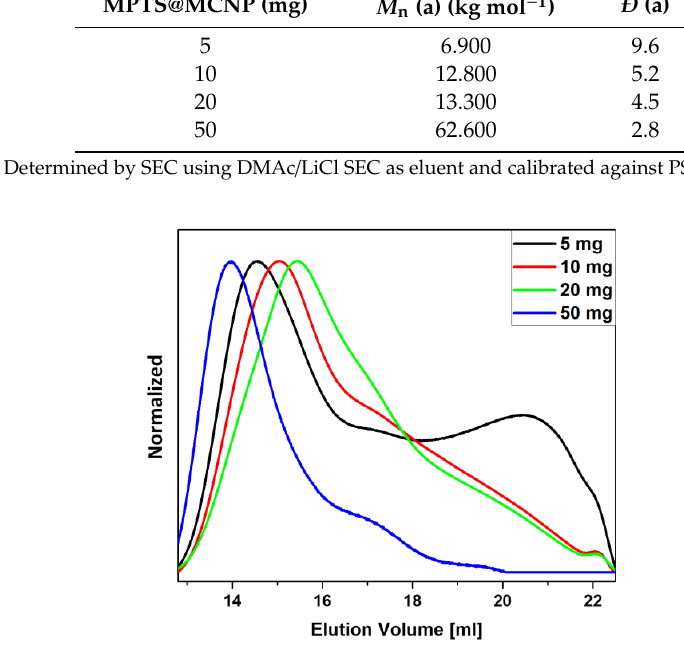
Table 4. SEC results for PS obtained by free radical polymerization in the presence of di ff erent amounts of MPTS@MCNP as chain transfer agent